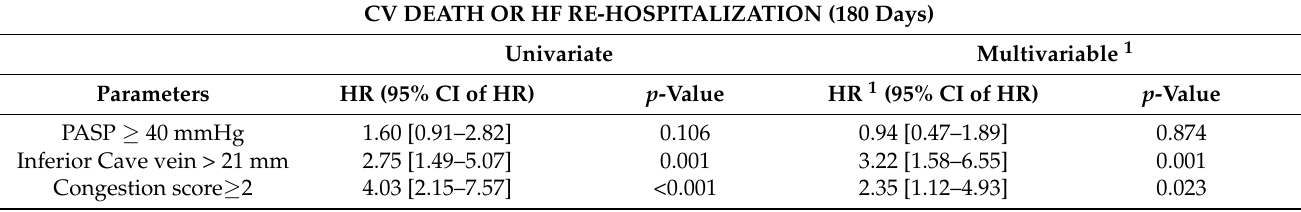
Table 2. Univariate and multivariable analysis for 180 days outcome